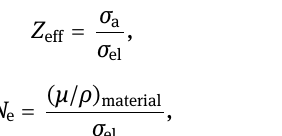
01E+252E+253E+254E+255E+256E+257E+258E+259E+25 Figure 9: The N e ff distribution as a function of gamma - ray Figure 10: The calculated C e ff as a function of gamma - ray energies.